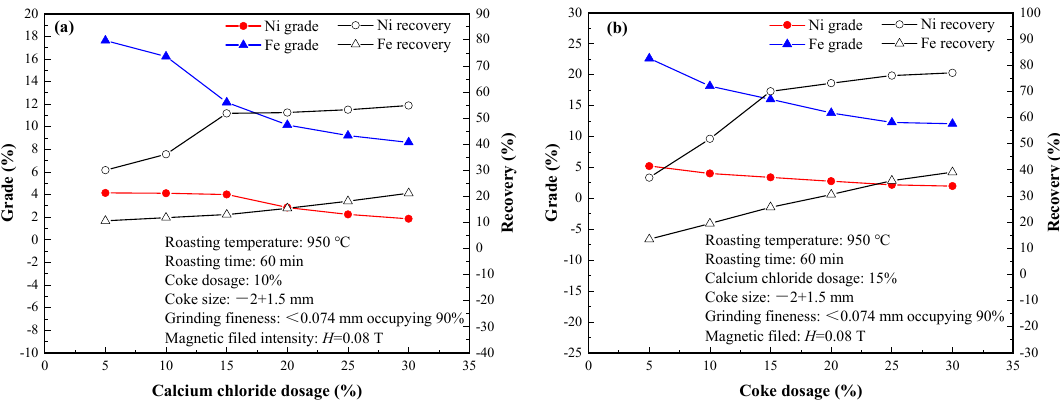
Figure 3. Effect of calcium chloride dosage ( a ) and coke dosage ( b ) on nickel extraction.